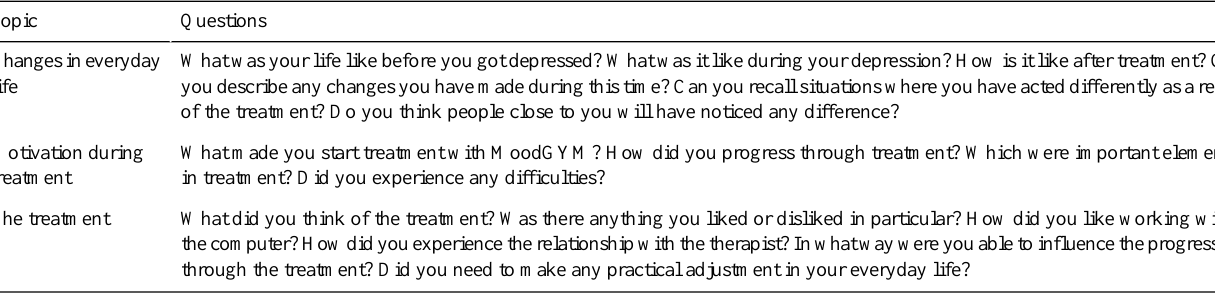
Table 1. Main questions in the interview